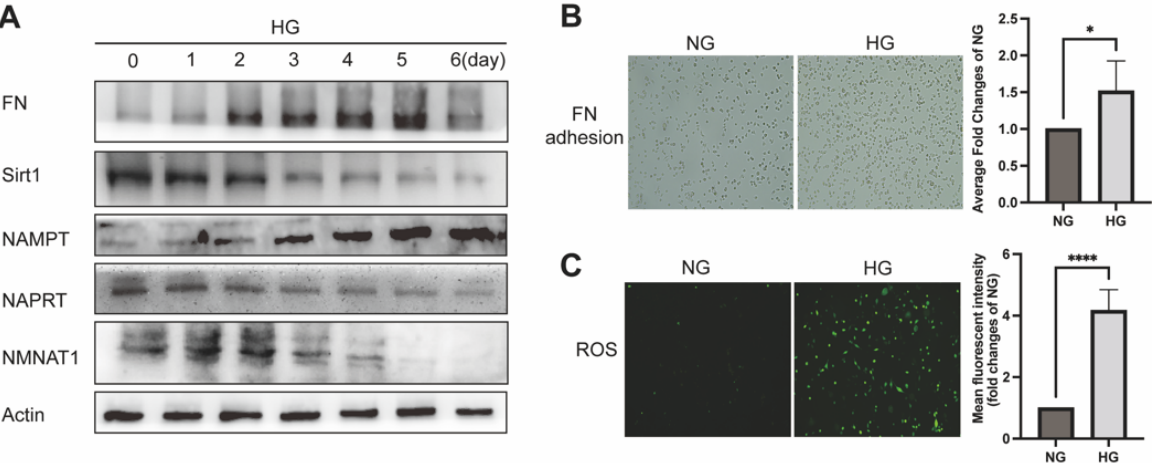
Figure 1. Effect of HG on NAD + -related enzymes and MSC injury: ( A ) Western blot analyzed NAD + -related enzymes and fibrotic injury of 0 to 6 days HG on MSC for FN, NAMPT, NAPRT, Sirt1, and NMNAT1 levels; β -actin was used as a loading control. ( B ) FN adhesion assayed adhesion and ( C ) DCFH-DA assayed ROS levels of MSC. 20 × 10 magnification; * p ≤ 0.01, **** p ≤ 0.0001; n = 3 independent samples; data represent mean ± SD; t -test analysis.